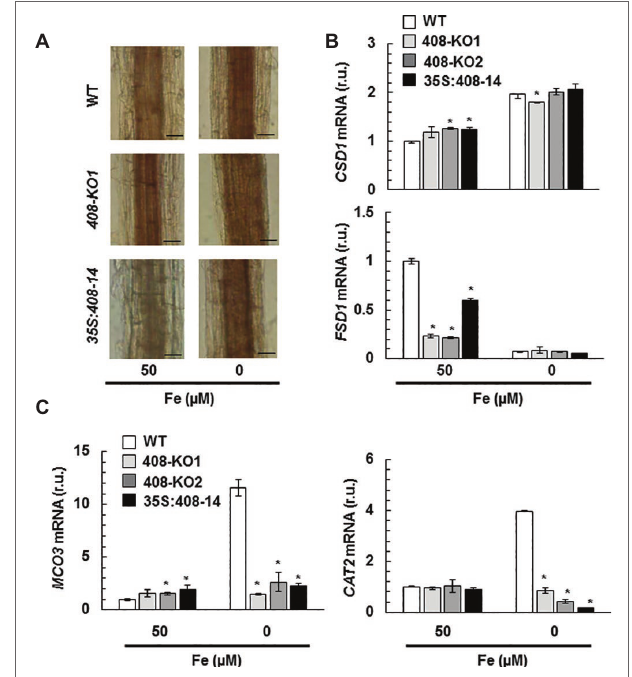
FIGURE 7 | Hydrogen peroxide detection in the plants with altered miR408 expression. (A) Hydrogen peroxide detected in the roots of the 15-day-old wild-type (WT), 408-KO1, and 35S:408-14 seedlings grown in 50 and 5 μ M Fe citrate media. Photographs of the representative roots, where a brown polymerization product was formed by the reaction of hydrogen peroxide with diaminobenzidine tetrahydrochloride. n = 15 plants were stained for each genotype and condition. The length of the bars indicates 100 μ m in 50 and 5 μ M Fe citrate. (B) FSD1 and CSD1 (C) CAT2 and MCO3 relative expression. The 7-day-old wild-type (WT), 408-KO1, 408-KO2, and 35S:408- 14 seedlings grown in 1/2 MS medium containing 50 and 0 μ M Fe citrate. Total RNA was extracted and analyzed by RT-qPCR with specific oligonucleotides for FSD1 , CSD1 , CAT2 , and MCO3. The UBIQUITIN10 gene was used for data normalization, and the expression is shown in relative units (r.u.). Values correspond to the arithmetic means (2 −∆∆Ct ) ± standard deviation of at least three biological replicates ( n ≥ 25 plants). Asterisks indicate significant differences for the same group of samples versus the WT line ( p < 0.05) based on the pair-wise fixed reallocation randomization